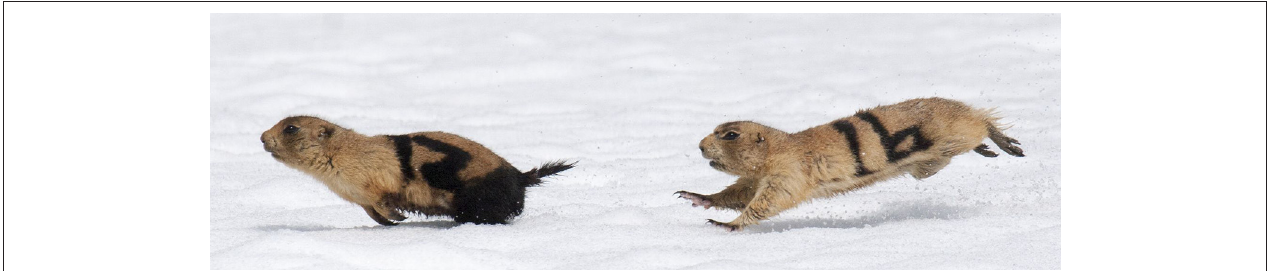
FIGURE 3 | Earatagged, marked prairie dogs. Here male-16 (right) chases male Black-bottom-12 (left) during the mating season. Note silver eartag in left ear of each male. Every year, each WTPD at the study colony had a unique marker (with Nyanzol fur dye) and two National eartags with unique numbers. Photo by Elaine Miller Bond, www.elainemillerbond.com (Reproduced with